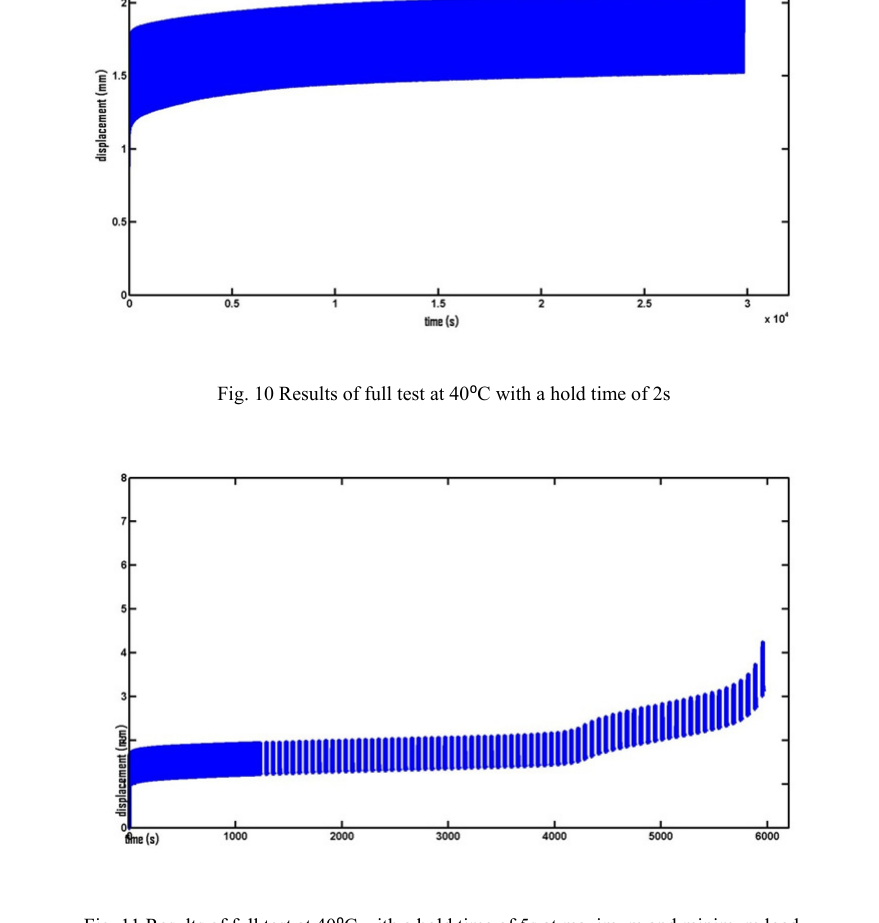
Fig. 11 Results of full test at 40 ⁰ C with a hold time of 5s at maximum and minimum